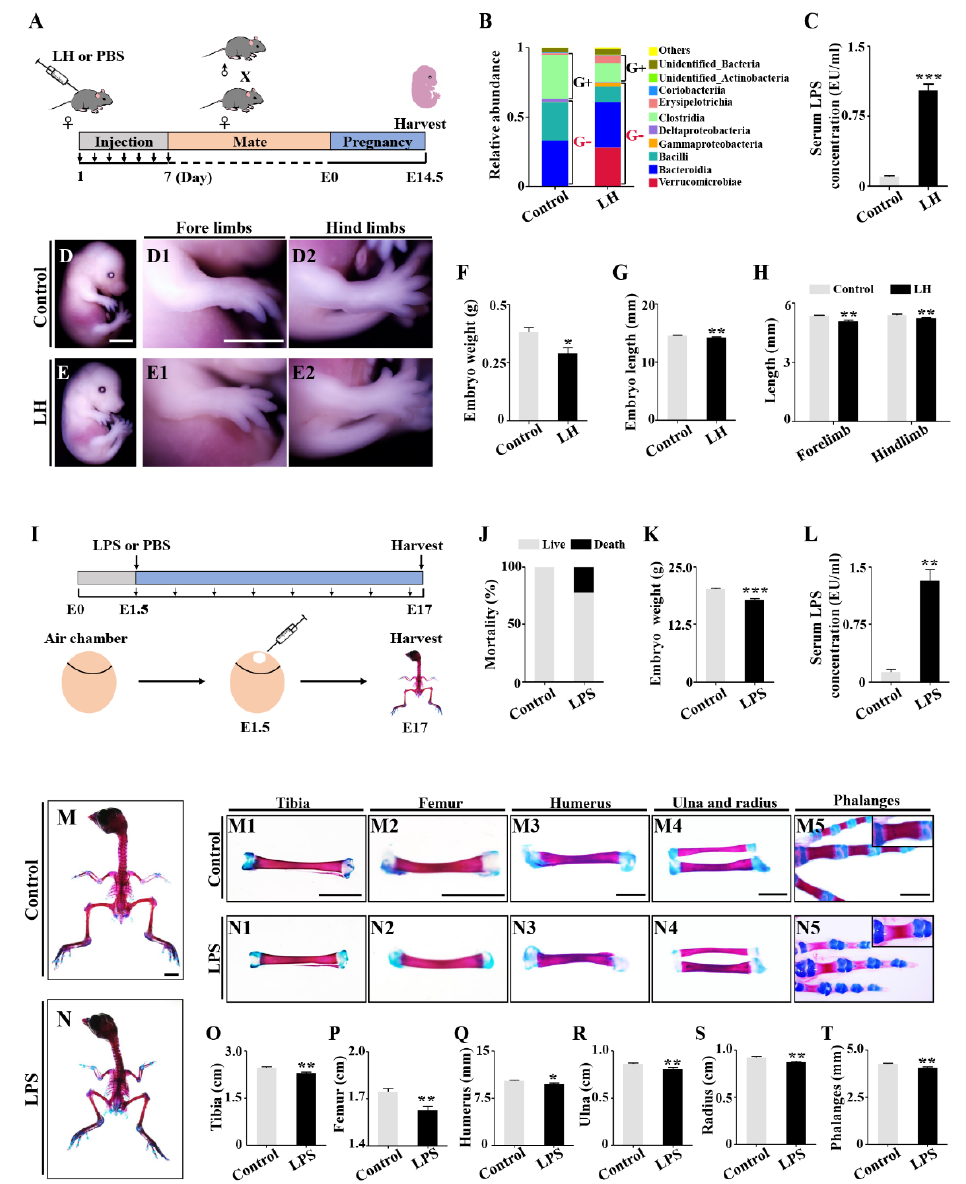
Figure 1. Assessing the development of mouse embryos from dysbacteriosis pregnant mice and the chick embryos treated with lipopolysaccharide (LPS). ( A ) Sketch illustrating the mouse model of lincomycin hydrochloride (LH)-induced dysbiosis of intestinal microbiota. ( B , C ) Bar charts showing the relative abundance of main bacteria in mouse guts at the class level of control and LH-treated groups ( B ) and the LPS level in mice serum ( C ). ( D – E2 ) Representative bright-field images of E14.5 mouse embryos of control ( D ) and LH-treated ( E ) groups. High magnification images for forelimb ( D1 – E1 ) and hindlimb ( D2 – E2 ). ( F – H ) Bar charts showing embryo weights ( F ), lengths ( G ), as well as the lengths of forelimbs and hindlimbs ( H ) of control and LH-treated groups. ( I ) Sketch illustrating the model of LPS-treated chick embryos. ( J – L ) Bar charts showing embryo mortality ( J ), weights ( K ), as well as the serum LPS levels ( L ) of control and LPS-treated E17 chick embryos. ( M , N , M1 – N5 ) Representative Alcian blue / alizarin red whole-stained images of E17 chick embryos of control ( M ) and LPS-treated ( N ) groups. High magnification images of tibia ( M1 , N1 ), femur ( M2 , N2 ), humerus ( M3 , N3 ), ulna / radius ( M4 , N4 ), and phalanges ( M5 , N5 ). ( O – T ) Bar charts comparing the length of tibia, femur, humerus, ulna, radius, and phalanges between control and LPS-treated groups. Scale bars = 3 mm in ( D – E , D1 – E1 , D2 – E2 , M3 – M5 , N3 – N5 ); 10 mm in ( M – N , M1 – M2 , N1 – N2 ). (* p < 0.05, ** p < 0.01, *** p < 0.001)